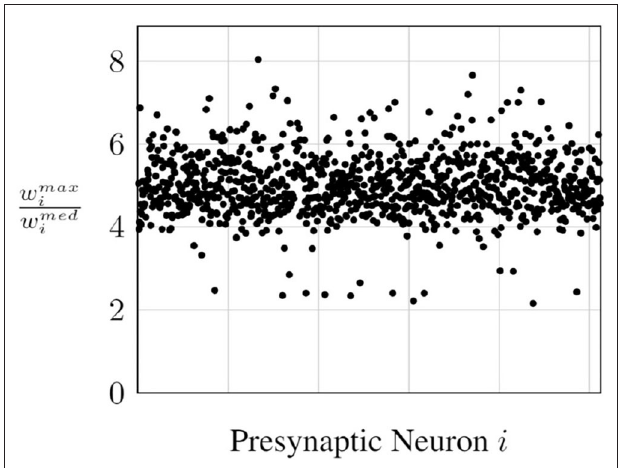
FIGURE 6 | Effect of clustering on probabilities of